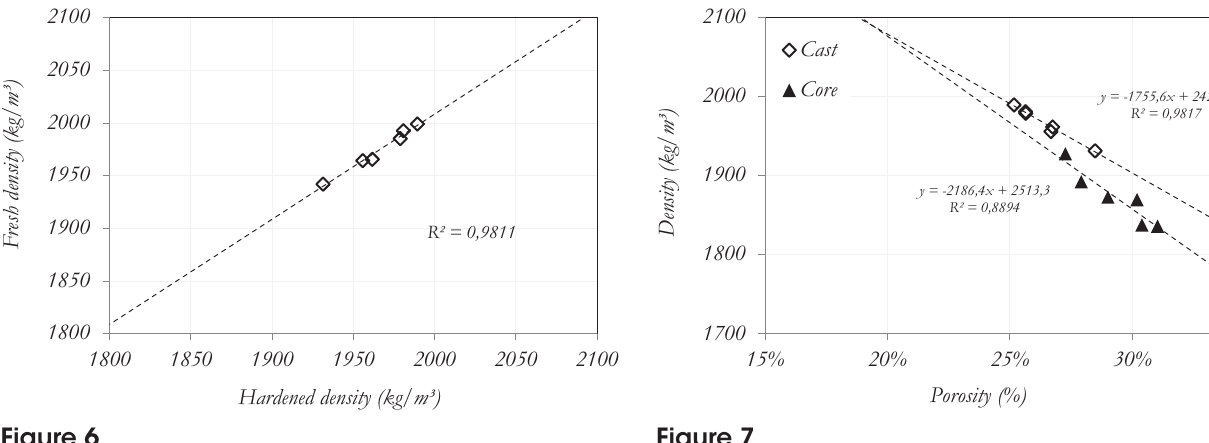
Figure 6 Fresh density vs. hardened density of cast cylindrical specimens